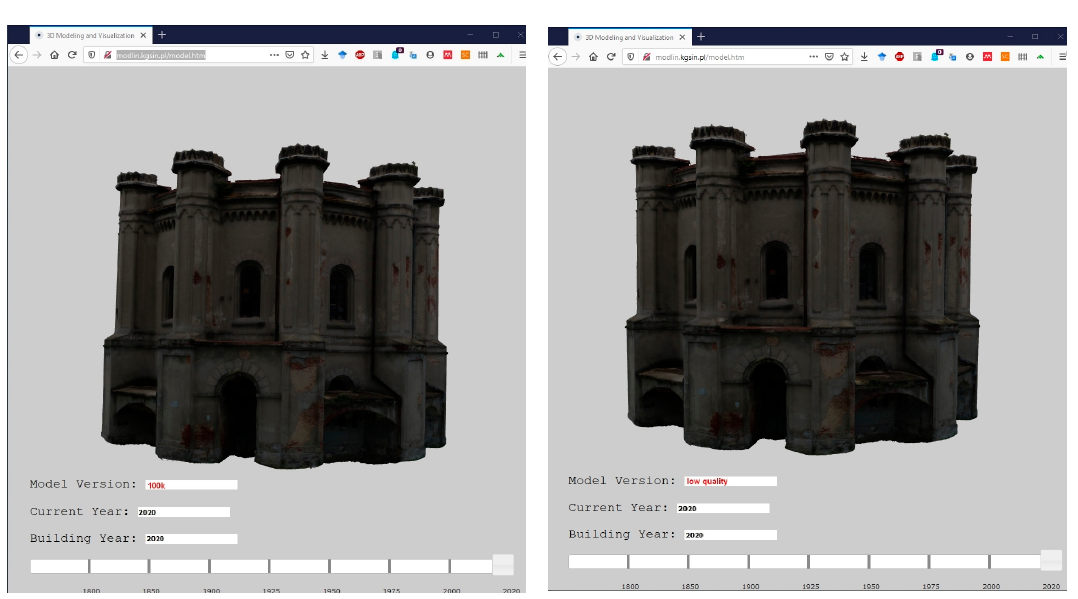
Figure 15. Visualization of the water station building model as a dae models in 3D web GIS environment.